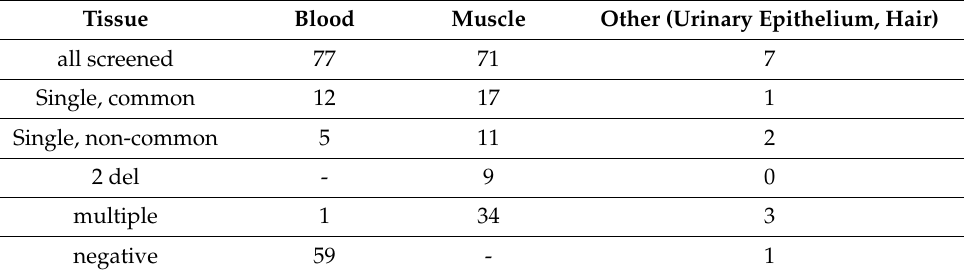
Abbreviations: del—deletion, “-”—no